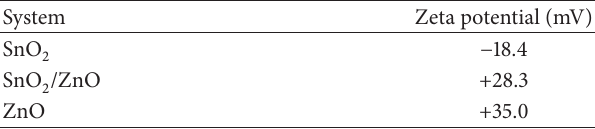
Table 3: Zeta potential values for SnO 2 /ZnO composite